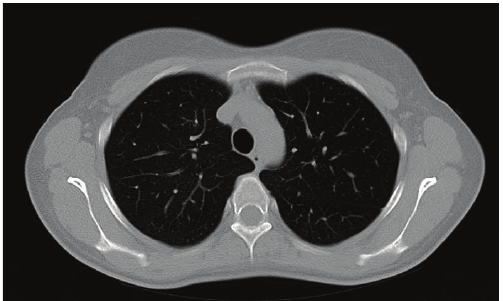
Figure 4: CT-scan of the same region depicted in Figure 3, three months later, showing complete remission of the right component of the bilateral